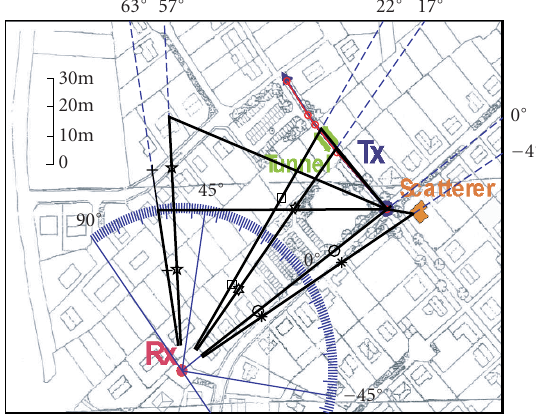
Figure 3: Map of the measurement scenario in Weikendorf.